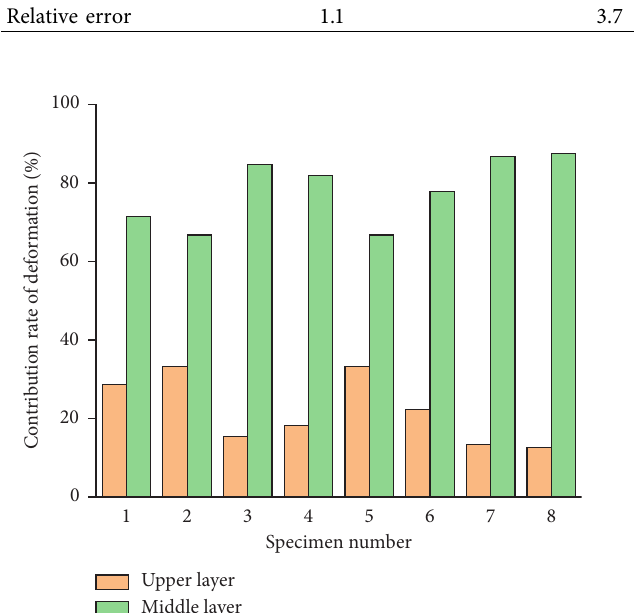
Figure 13: Deformation contribution rate of each layer for the specimens. The structure type of specimen numbers 1 and 2 is AC- 13-MOH. The structure type of specimen numbers 3 and 4 is MOH-AC-20. The structure type of specimen numbers 5 and 6 is MOH-MOH. The structure type of specimen numbers 7 and 8 is AC13-AC20. Table 6: Deformation contribution rate of each layer for different pavement